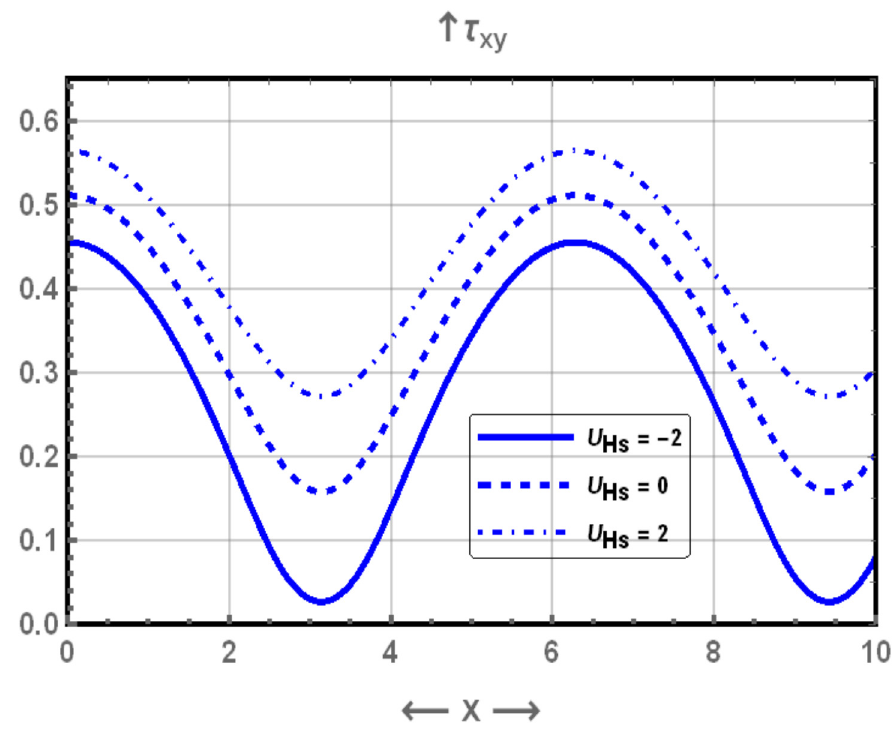
Figure 2. Display of shear stress profile for different values of U HS .